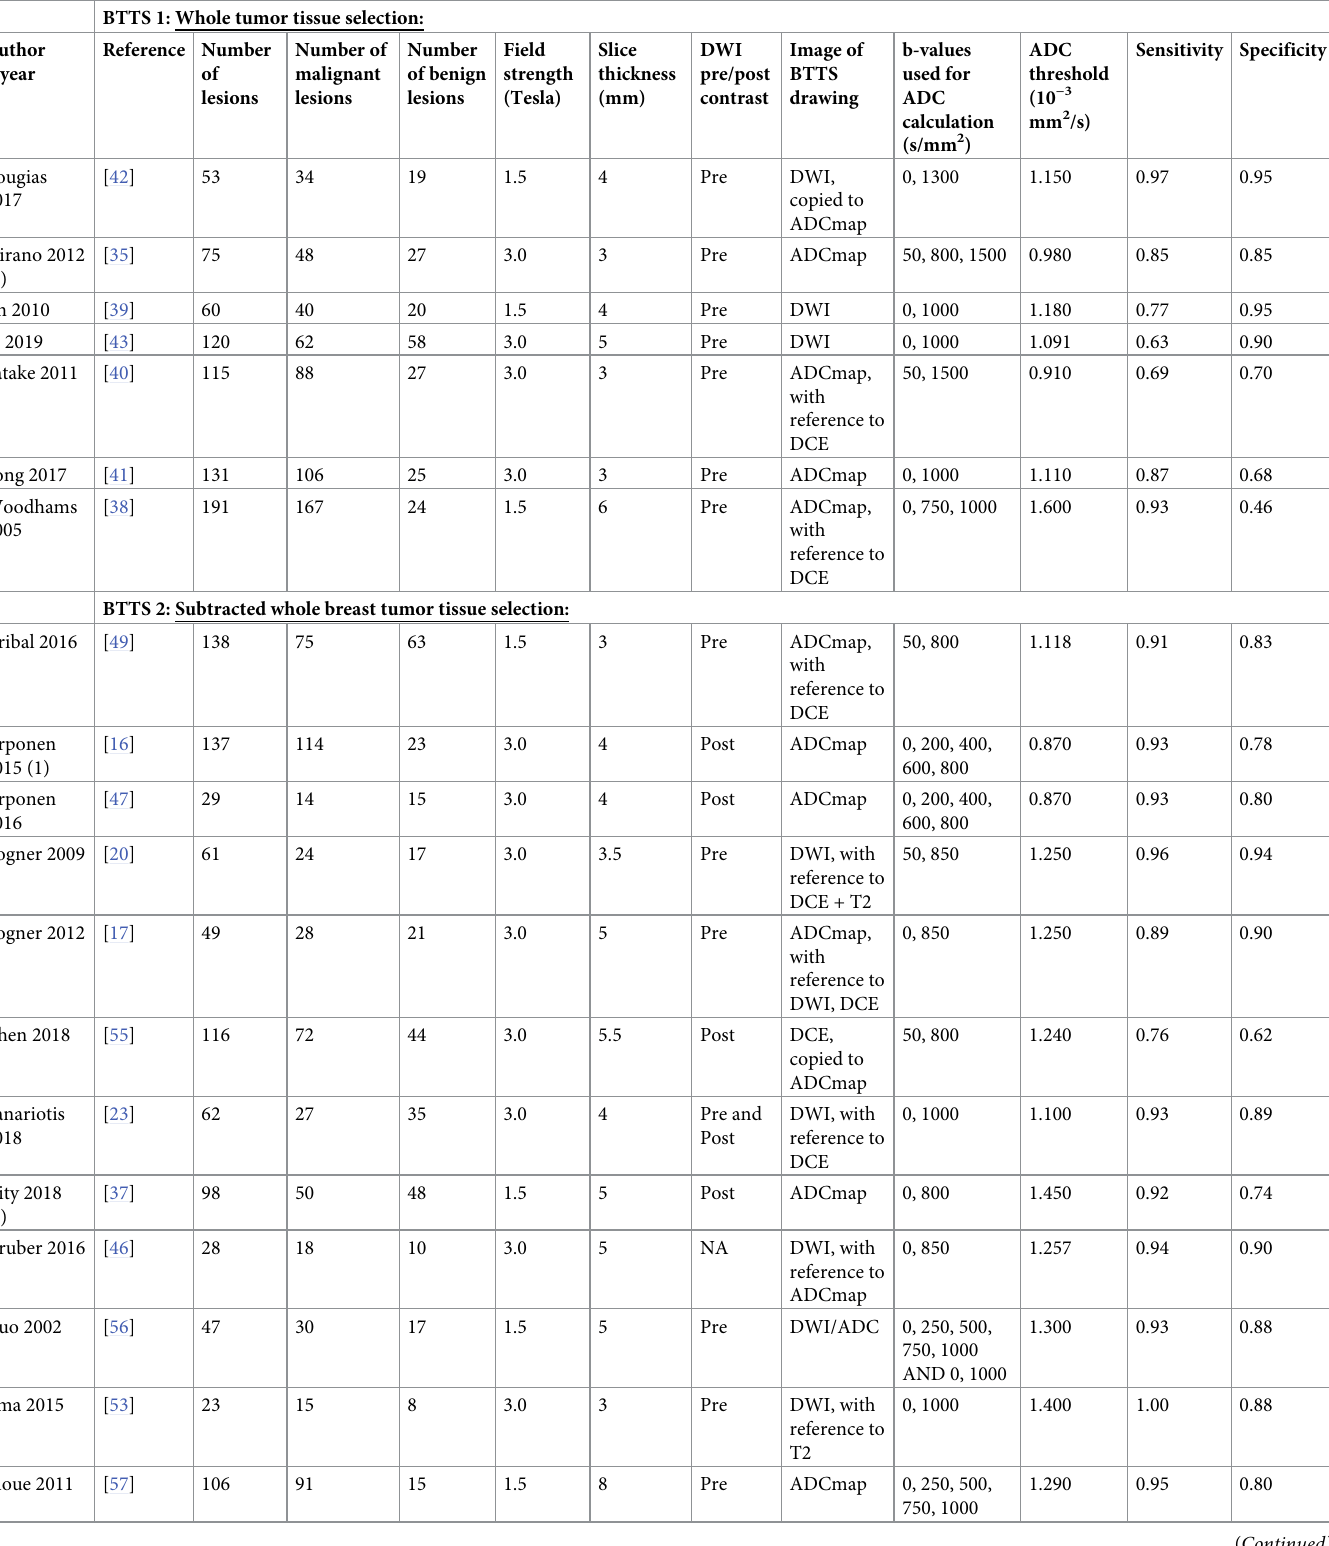
Table 1. Characteristics of the included study subsets grouped per breast tumor tissue selection (BTTS) method. BTTS 1: Whole tumor tissue selection: